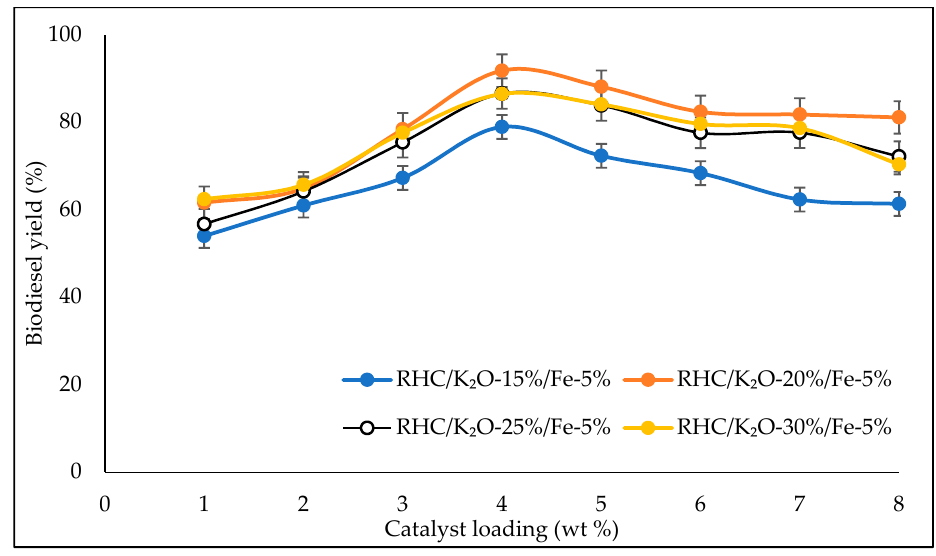
Figure 6. Screening of supermagnetic nano-bifunctional catalyst based on the catalyst loading for transesterification reaction with methanol: oil; 10:1, at temperature 65 ° C for 4 h.